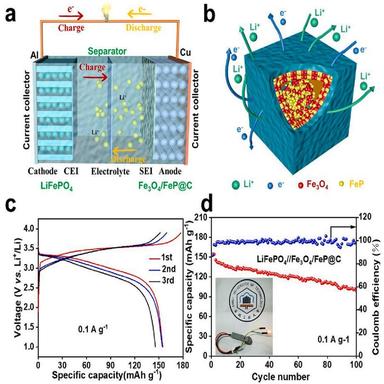
Schematic illustration of the Li+ insertion and extraction process in Fe3O4/FeP@C (a) and the LFP@C//Fe3O4/FeP@C full cell (b). (c) Galvanostatic charge/ discharge profiles and (d) cycling performance at 0.1 A g− 1 of the LFP@C//Fe3O4/FeP@C full cell, and a red bulb powered by the full cell as inset.